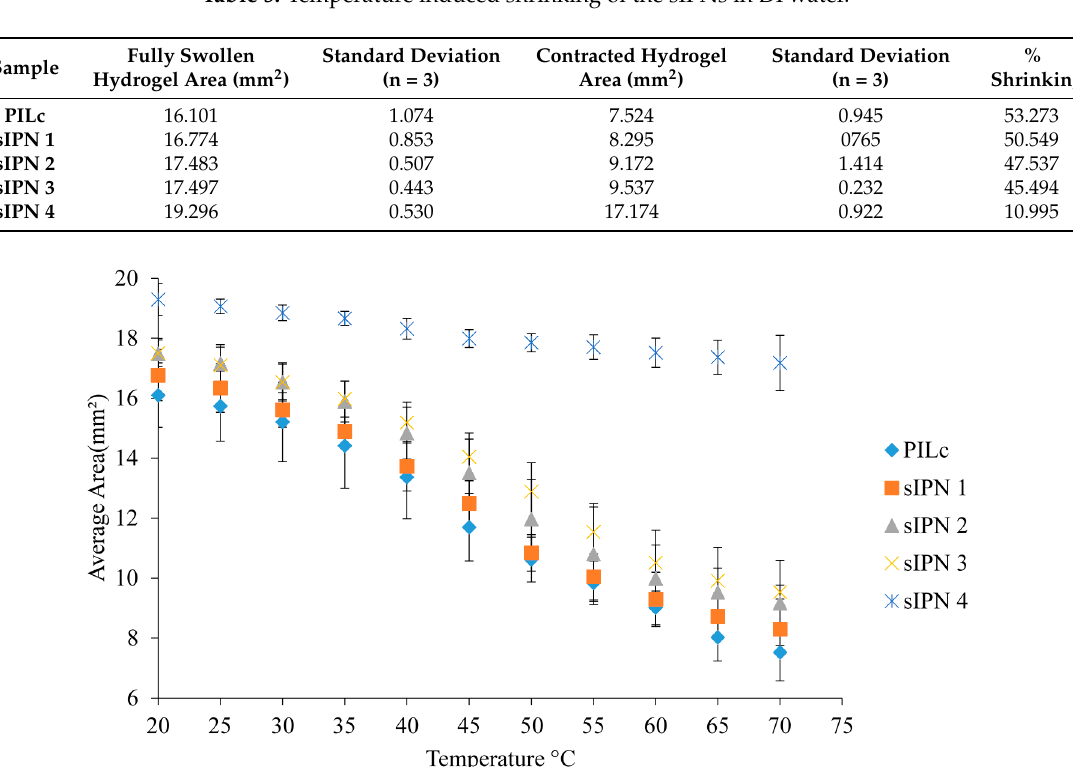
Table 5. Temperature induced shrinking of the sIPNs in DI water.